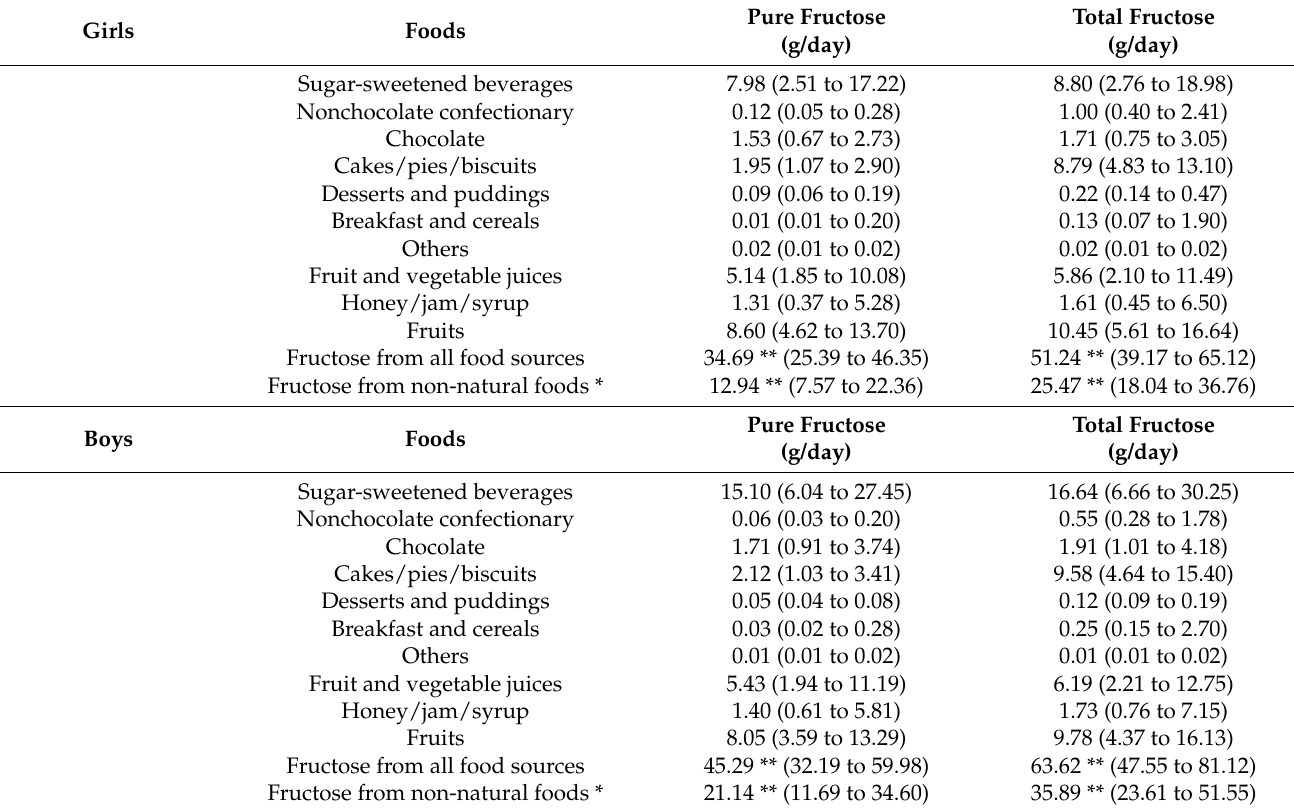
Table 1. Daily fructose intake from various fructose-containing foods in girls and boys.